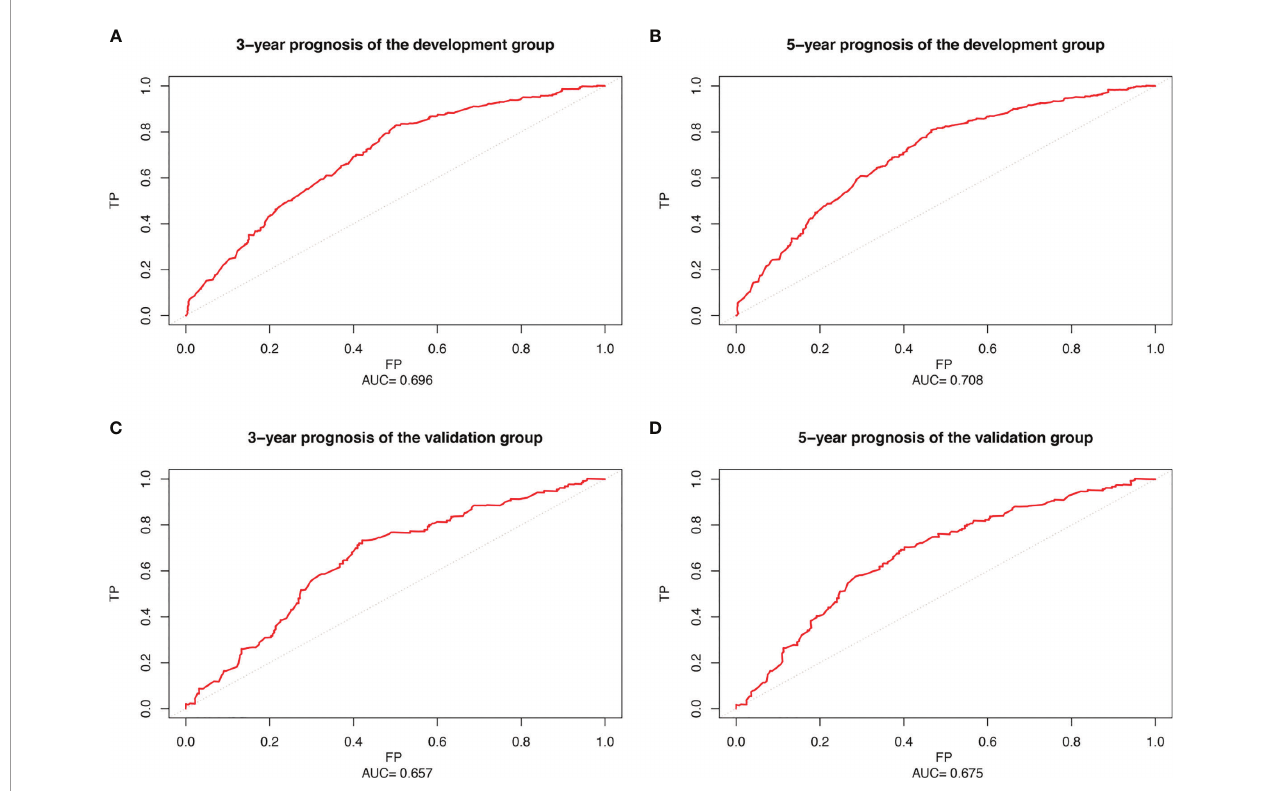
FIGURE 6 | Receiver operating characteristic curve (ROC) of patients with WHO Grade III meningioma. (A) 3-year ROC of the development set; (B) 5-year ROC of the development set; (C) 3-year ROC of the validation set; (D) 5-year ROC of the validation